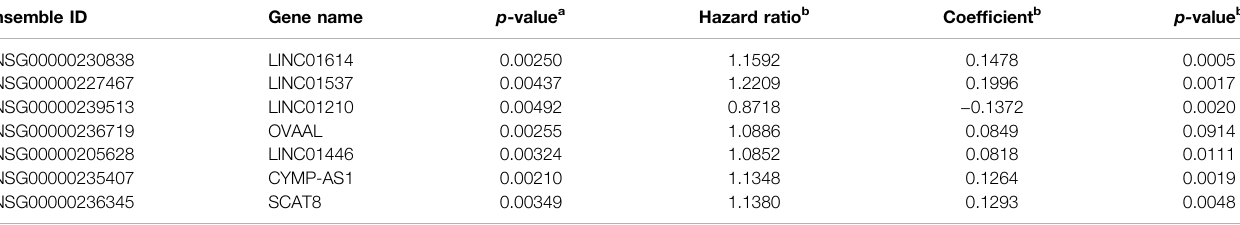
TABLE 1 | The information of seven prognostic differentially expressed long non-coding RNAs which showed correlation with the overall survival of gastric cancer patients. Ensemble ID